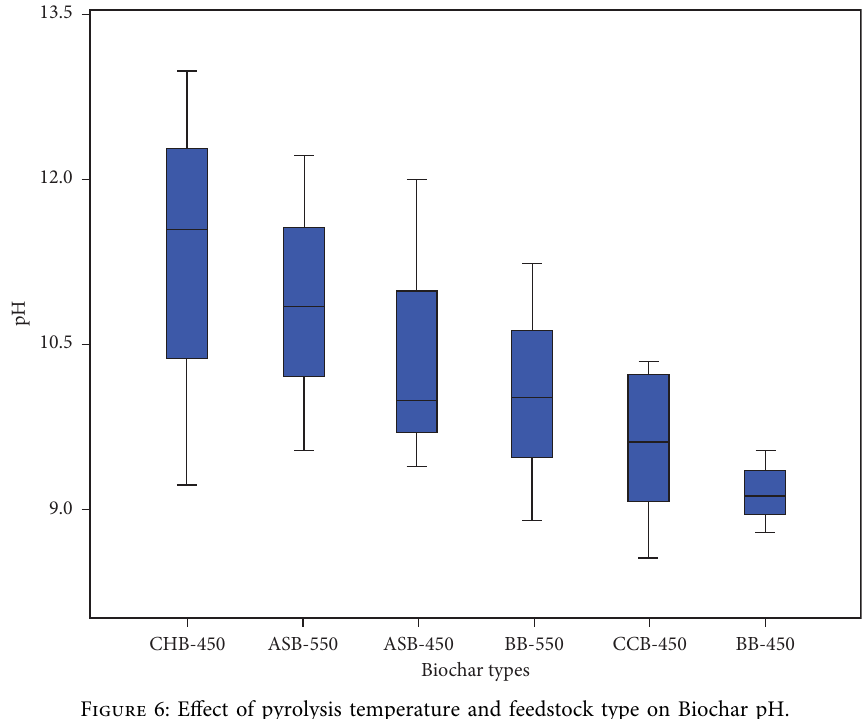
Figure 6: Efect of pyrolysis temperature and feedstock type on Biochar pH.